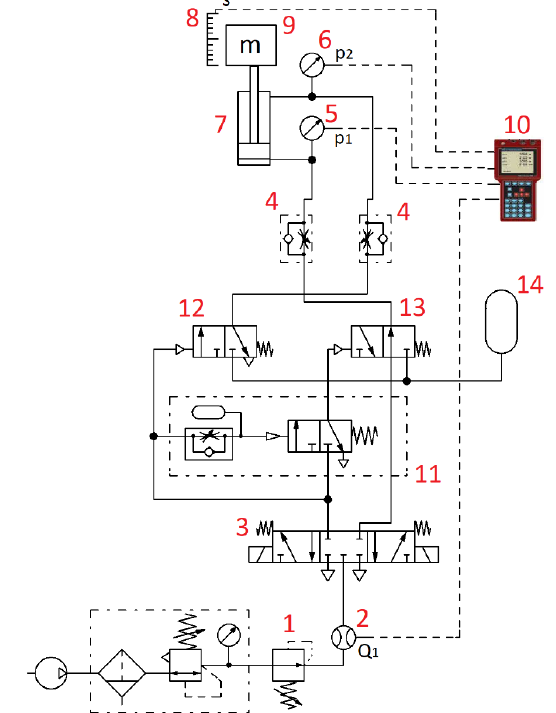
Fig. 11. The scheme of measurement with reservoir to